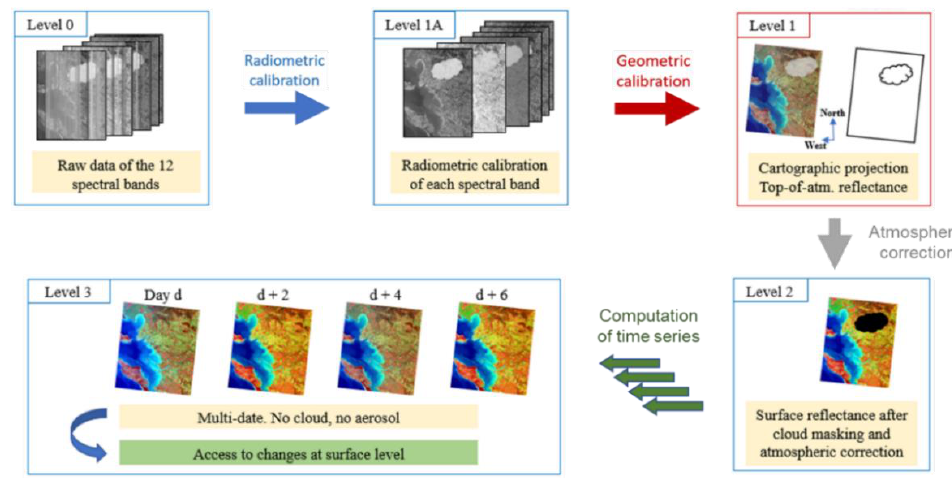
Figure 4. VENμS product levels and assoc iated processing. Figure 4. VEN µ S product levels and associated